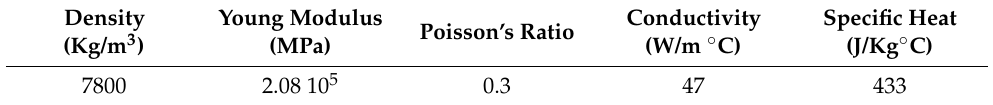
Table 8. Mechanical and thermal properties of workpiece material.